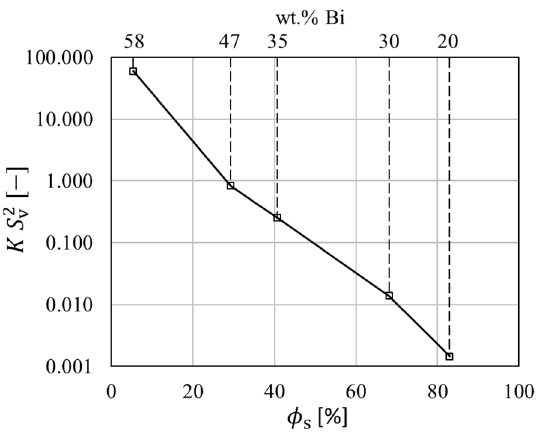
Figure 17. Dimensionless permeability over solid fraction (just before the final formation of the eutectic fraction) and Sn-Bi alloy composition, calculated from µ-XCT measurements.